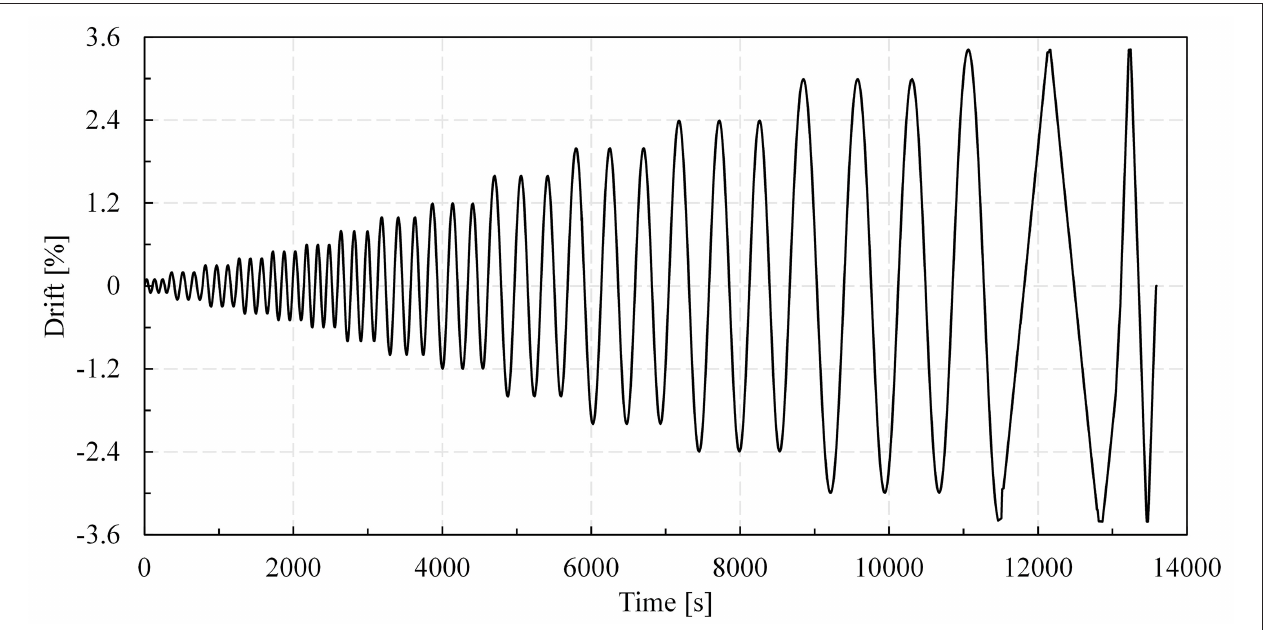
FIGURE 5 | In-plane test protocol adopted for infilled frames (up to 1.2% drift) and bare frame.